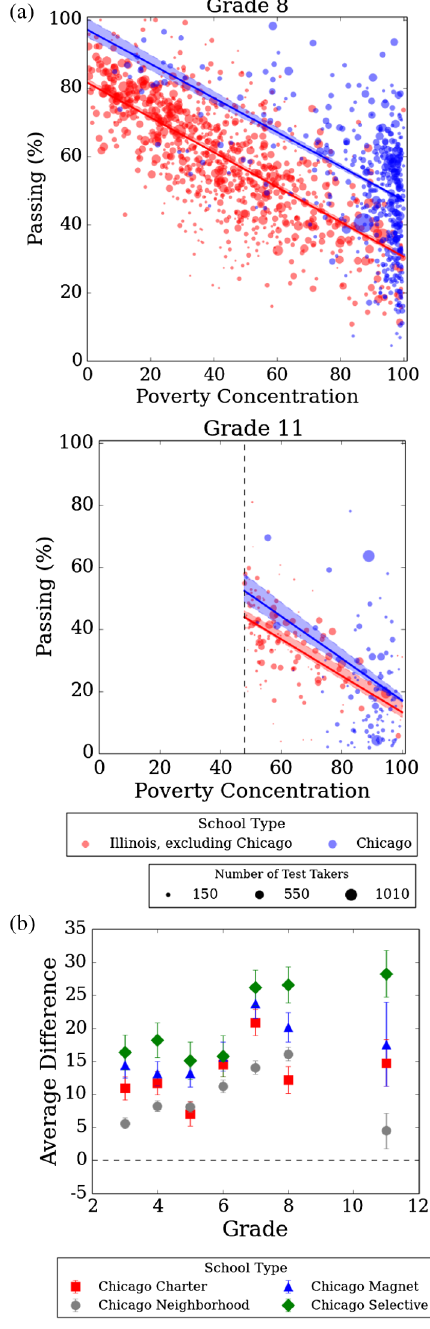
FIG. 4. (a) Math performance scores of Chicago schools (blue) are compared to the fit to the data of other Illinois schools (red) at 8th and 11th grades. (b) Average differences of 2013 math exam performance at Chicago school programs when compared to other Illinois schools. The average difference Δ of each school category is determined by Σ N i ½ p i − f i ð c i Þ(cid:2) = Σ N i , where p i is the percent passing at each school, f i is the expected performance at that grade level (given in Table II) based on the poverty concentration c i of the school, and N i is the number of students in each school of that category. The bars represent standard uncertainty. Table III gives the number of schools